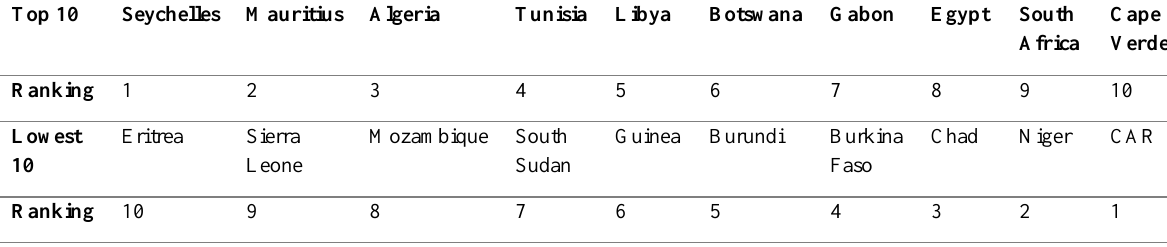
Table 2: Best 10 and 10 lowest developed African